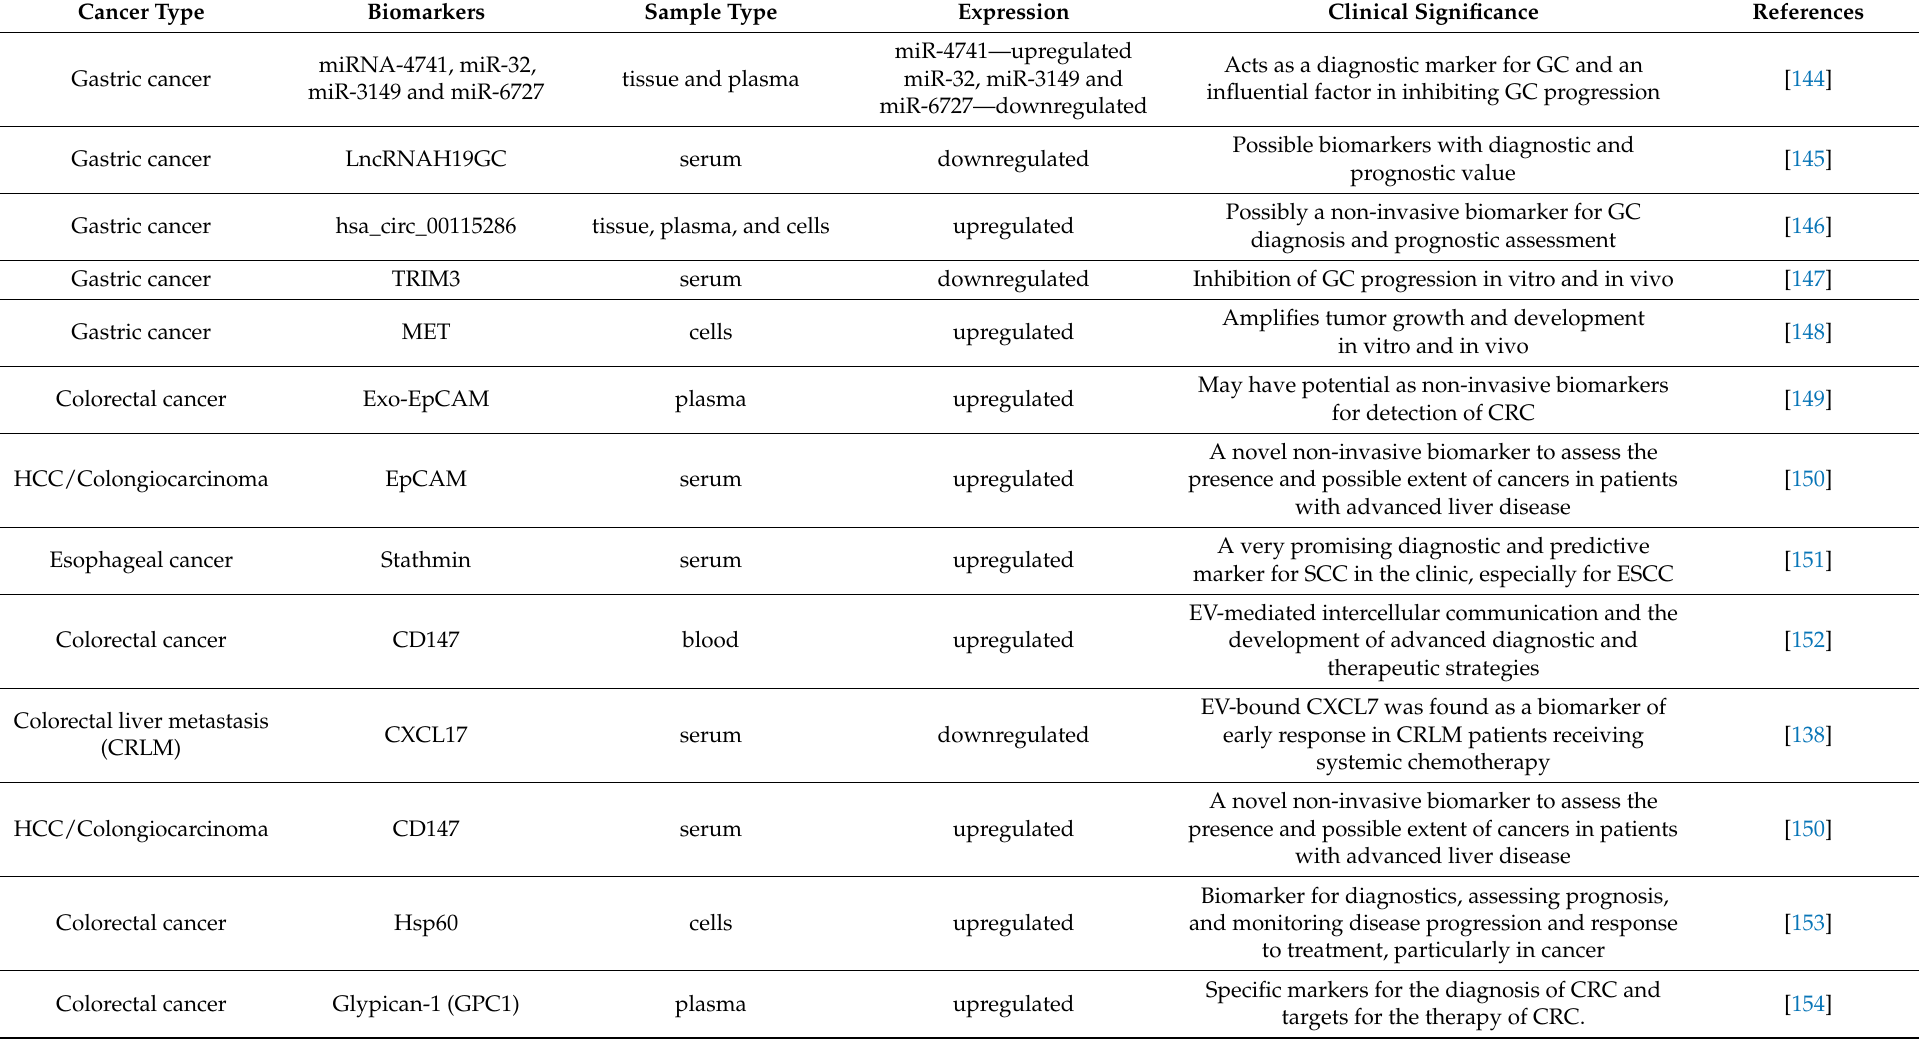
Table 3. Clinical relevance of Exosomes in